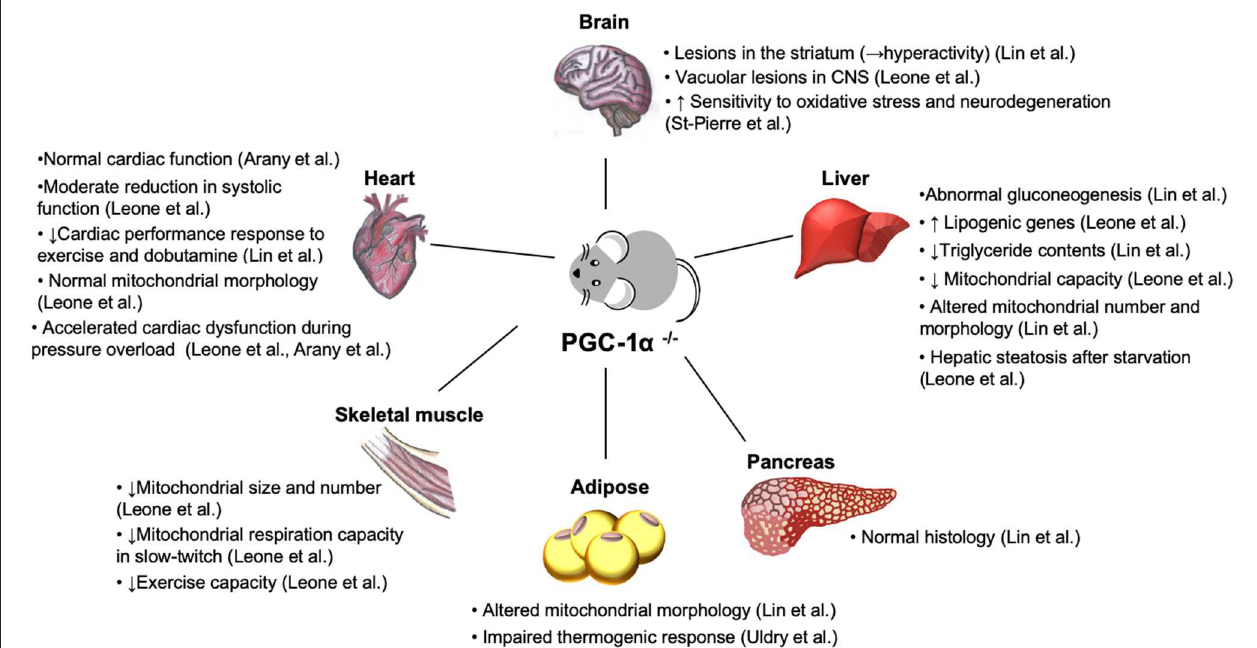
FIGURE 5 | Phenotypes of systemic PGC-1 α knockout mice. Loss of PGC-1 α leads to impaired energy homeostasis in a variety of organs (5, 21). Despite the reduced density and function of mitochondria in skeletal muscle (21) and abnormality in brown fat tissue with abundant accumulation of large lipid droplets (5), PGC-1 α knockout mice are paradoxically lean and resistant to diet-induced obesity due to hyperactivity, resulted from the lesions in the striatum in the brain (5). Normal cardiac function (7, 8) and moderate systolic dysfunction (21) have been reported in two different lines of PGC-1 α null mice. Nevertheless, both PGC-1 α − / − models show cardiac dysfunction in response to hemodynamic stress and metabolic challenge (8, 21). CNS, central nervous system.